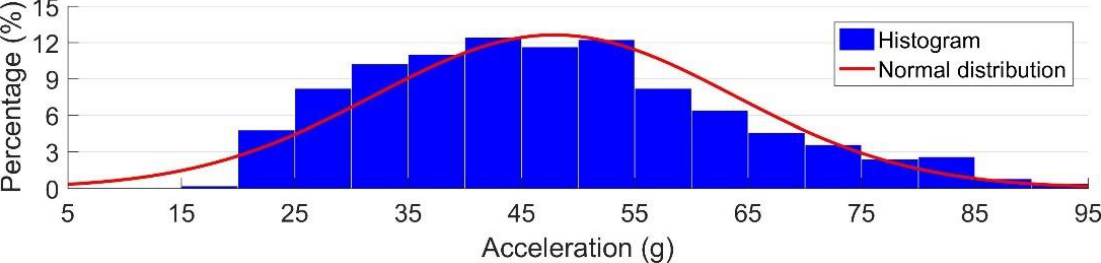
Figure 14. Histogram of the measured vertical accelerations used in the model validation.